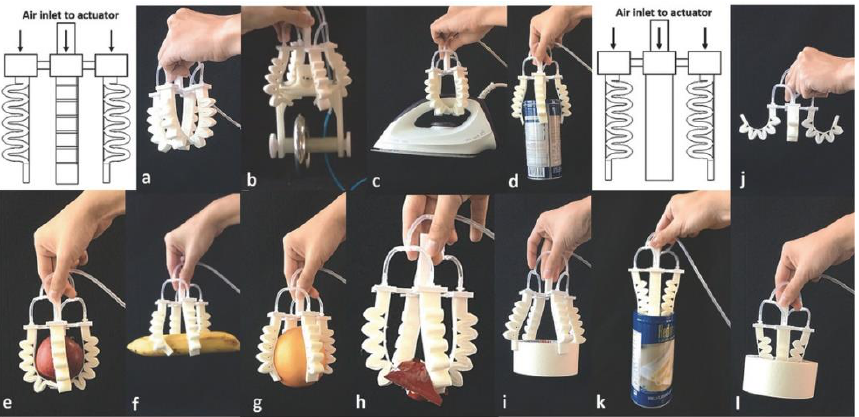
Figure 7. “ Demonstration of ( a ) robotic gripper equipped with 3D-printed pneumatic actuators picking up ( b ) a 0.94 kg structure and ( c – j ) items of different shapes, sizes, and weight using 175 kPa of pressure. ( j ) A second robotic gripper with outward-facing 3D-printed pneumatic actuators that can grasp ( k ) inside of a cylindrical can and ( l ) roll of tape. ” [B. A. W. Keong and R. Y. C. Hua, “A